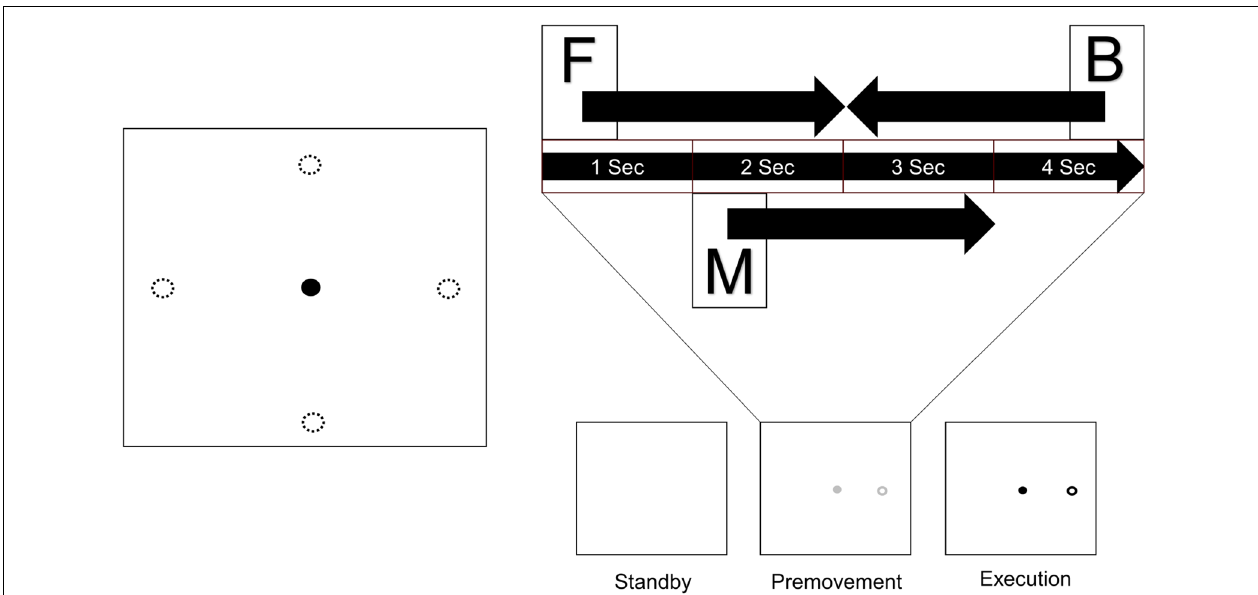
FIGURE 1 | Experimental design. A target appeared at one of four positions distributed 4 cm from the center in the horizontal and vertical directions. Each trial consists of three phases. When a trial started, nothing appeared on the screen (Standby), and subjects waited for the next phase. Next, a cursor and target appeared on the screen, and subjects prepared for movement execution (Premovement). When the color of the markers changed to black, subjects moved the cursor from the center to the target using the touchpad (Execution). Three windows from the premovement phase were used for analysis (F: window starting at onset of the premovement phase, M: window starting 1 s after onset of the premovement phase, B: window before the execution phase). Four sizes were used for each window (0.5 s, 1.0 s, 1.5 s, and 2.0 s).